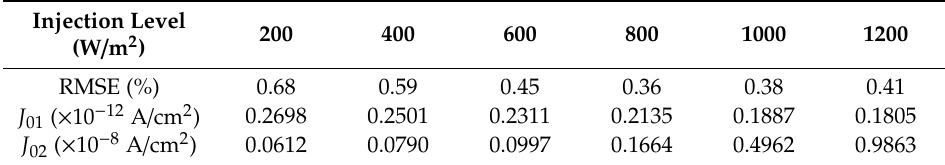
Table 3. The J 01 , J 02 , and RMSE of current density for a PERC solar cell.